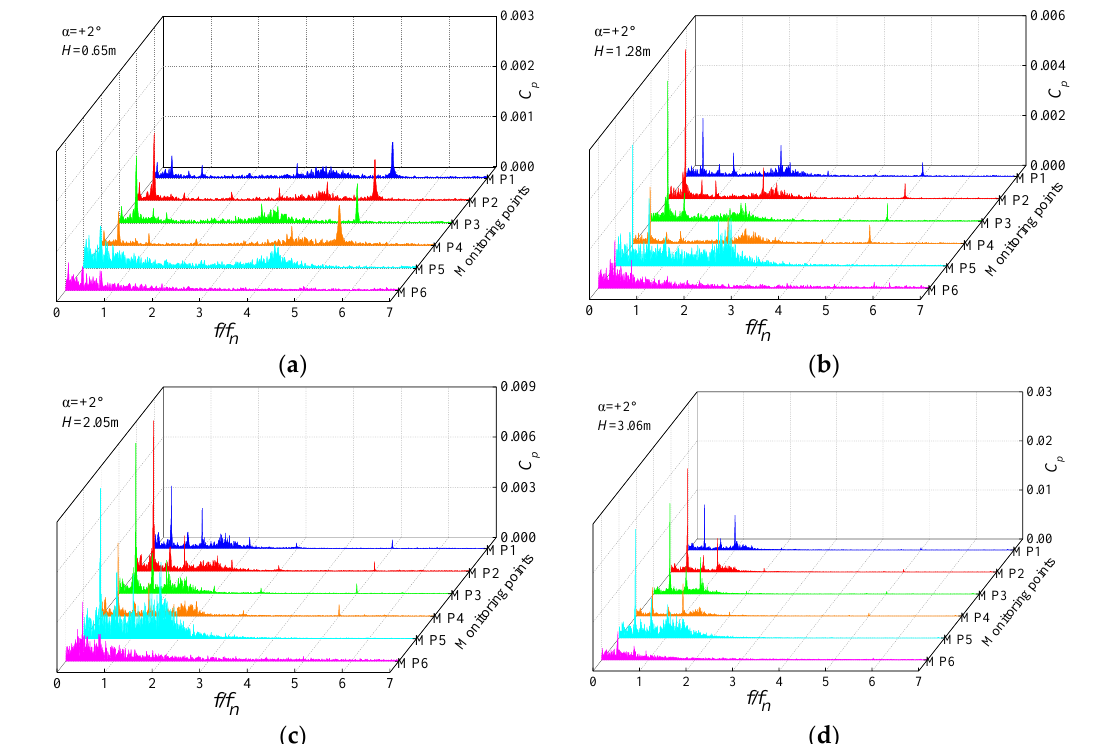
Figure 5. Comparison of frequency domain pressure pulsation coefficients of different MP at α = +2° with different runaway heads. ( a ) shows the pulsation coefficient curves at H = 0.65 m. ( b ) shows the pulsation coefficient curves at H = 1.28 m. ( c ) shows the pulsation coefficient curves at H = 2.05 m. ( d ) shows the pulsation coefficient curves at H = 3.06 m.